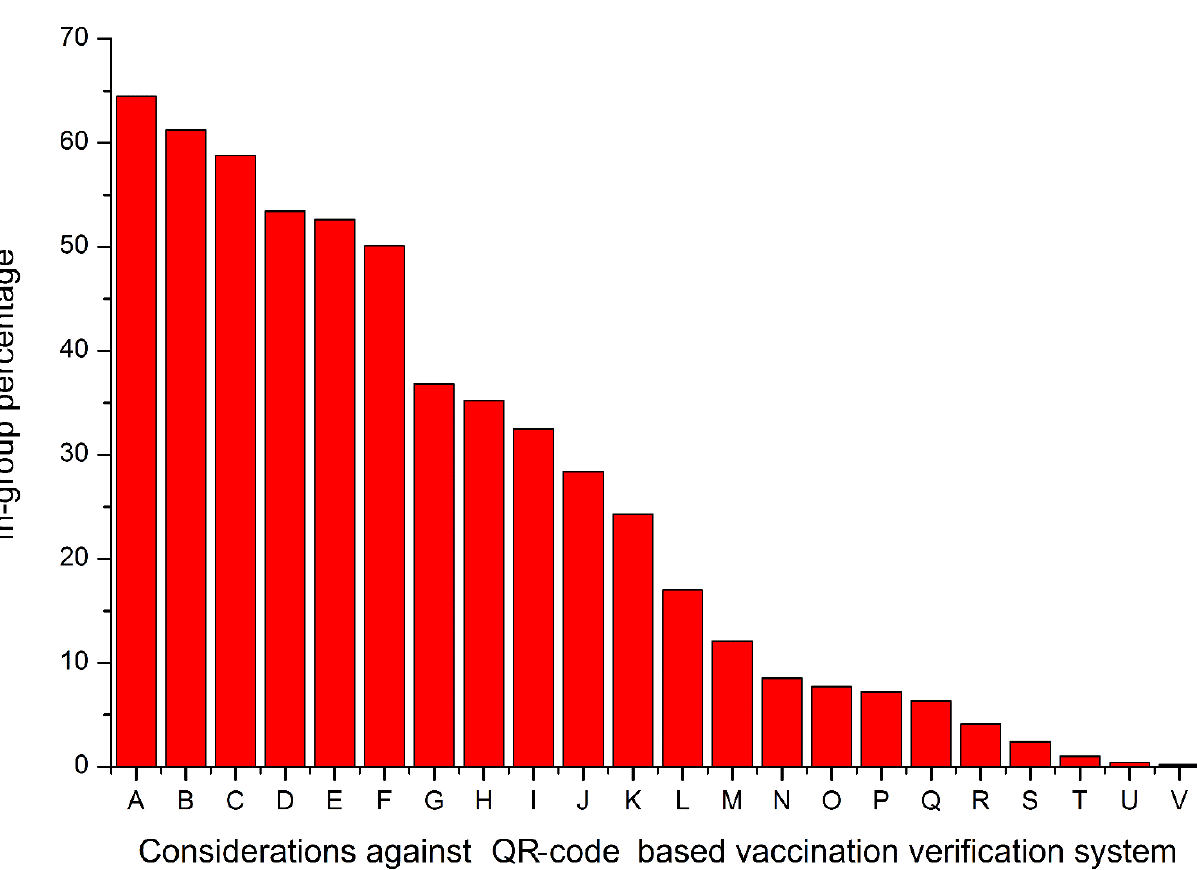
Figure 2. The frequency of occurrence of the main objections to introducing the nationwide system of vaccination certification/verification based on QR codes found in our survey. In-group percentage shows parts of a group of 5064 persons cautious about the planned QR code-based system. The legend is provided in Table 2. Table 2. The legend for Figure 2.